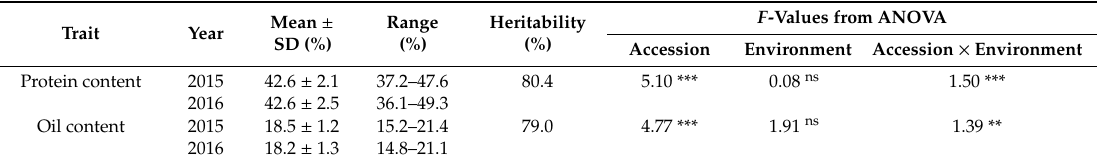
Table 1. Descriptive statistics, broad sense heritability and F -value from ANOVA for seed protein and oil content in the soybean association